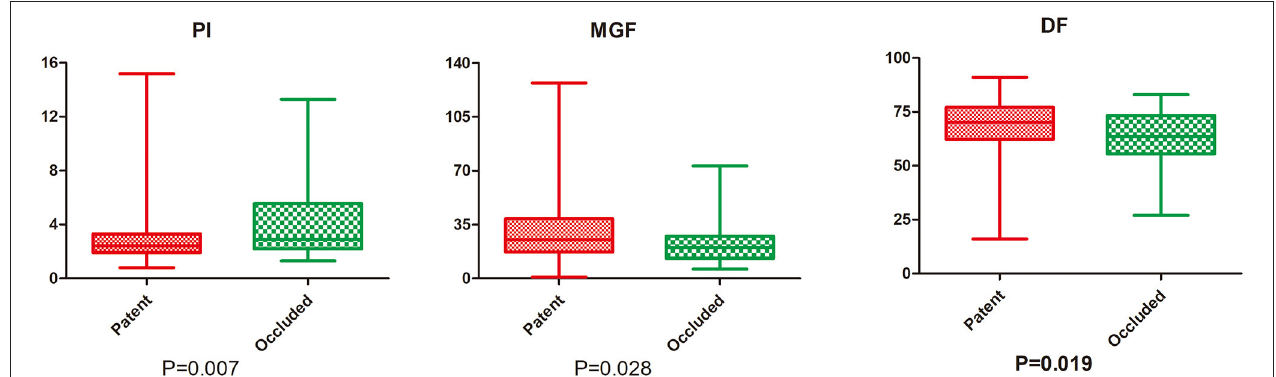
FIGURE 1 | ROC analysis of newly developed graft failure. PI, pulse index; MGF, mean graft flow; DF, diastolic flow fraction.